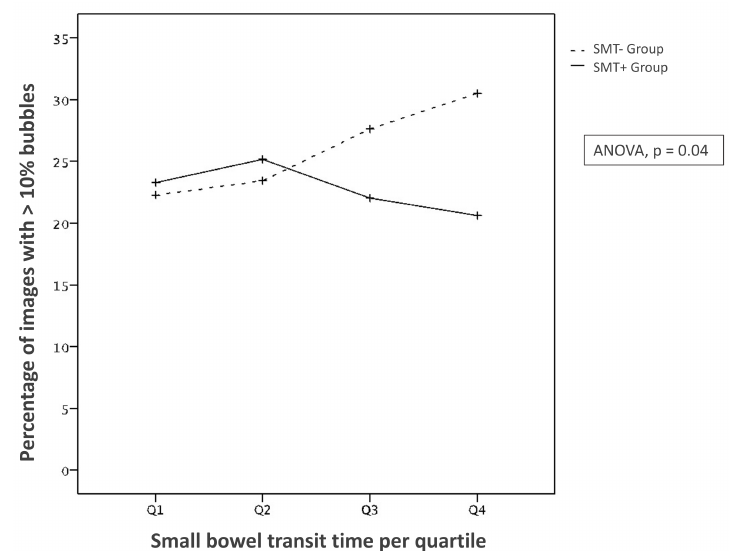
Figure 2. Interaction plot between the two groups about the percentage of images with more than 10% of bubbles over transit time (by quartile). SMT − stands for “without simethicone” whereas SMT+ means “with simethicone”.